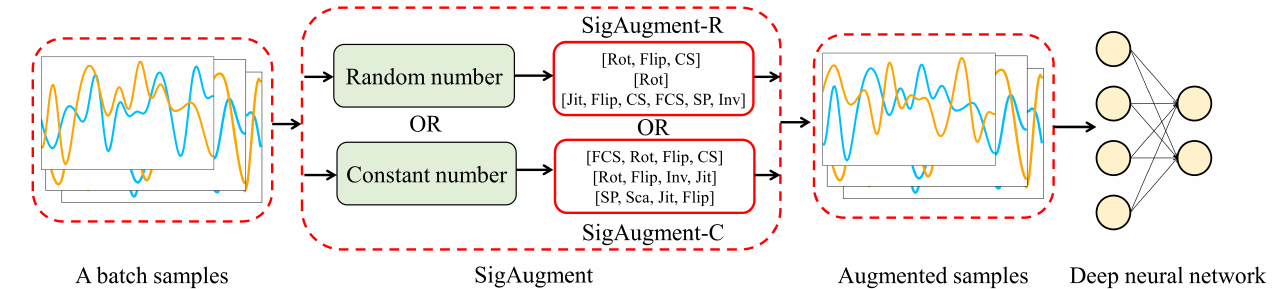
Figure 2. The proposed SigAugment and pipeline for online augmentation during model